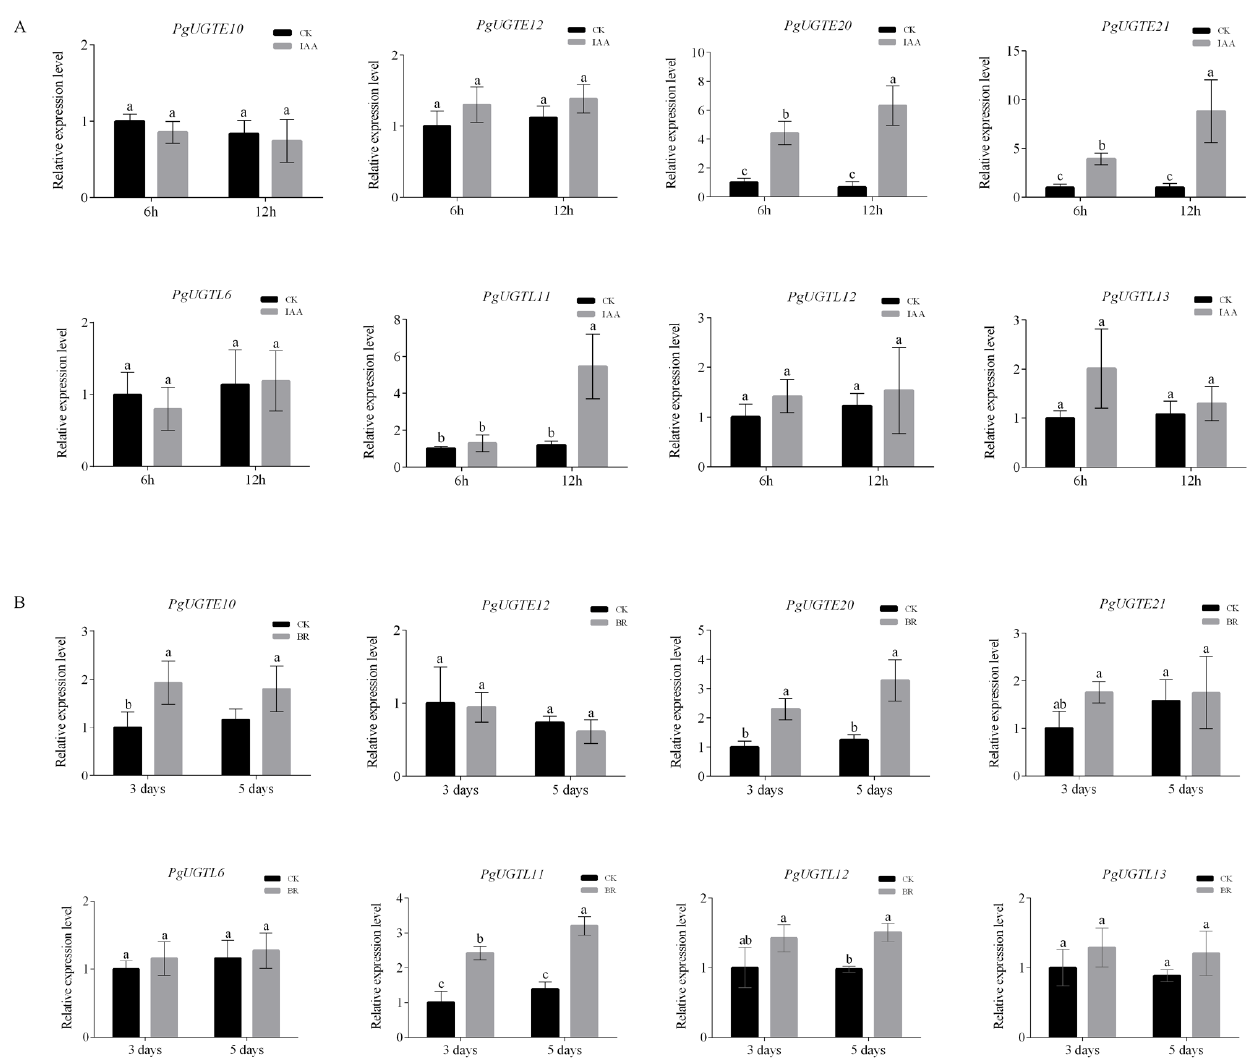
Figure 6. Expression analysis of PgUGT s under hormone treatment by qRT-PCR. ( A ) Relative expression levels of candidate PgUGT s in response to auxin treatment after 6 and 12 h. ( B ) Relative expression levels of candidate PgUGT s in response to BR treatment after 3 and 5 days. IAA, auxin; BR, brassinolide. Error bars indicate the standard deviation of three replications. Different letters indicate a significant difference at p < 0.05 using Tukey’s test.